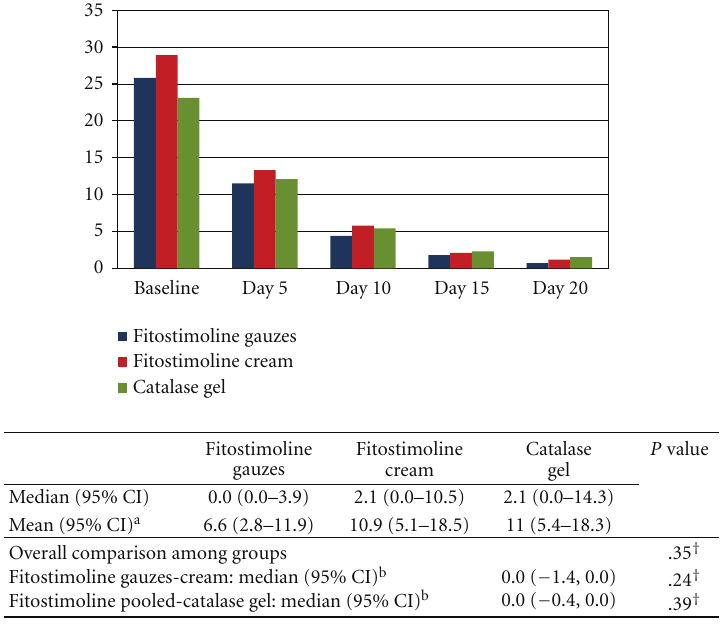
Figure 2: Mean values of lesion surface area (cm 2 ) during the study and results of comparisons between groups at Day 10 (e ffi cacy population).